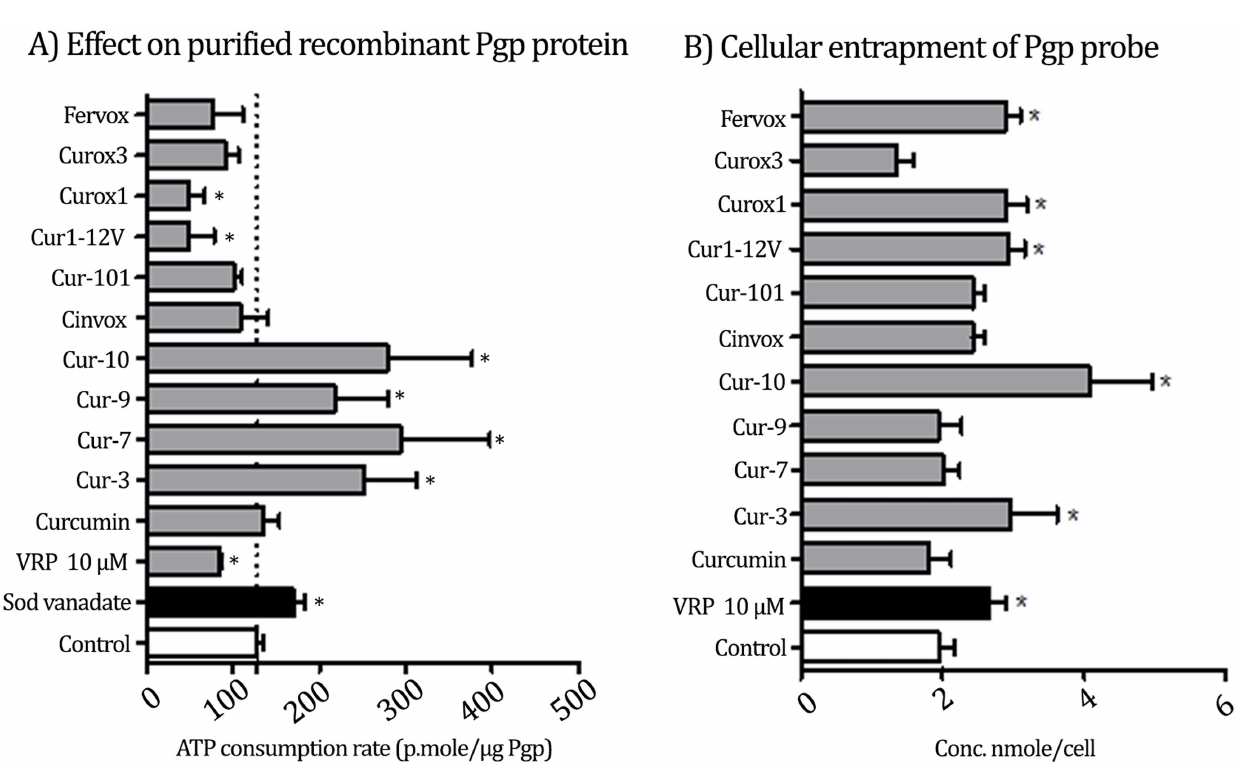
Fig 4. (A) The effect of test compounds on the activity of P-glycoprotein efflux pump cell free isolated recombinant P-gp protein and (B) within LS-174T cells. The influenceof test compoundson the cellularpharmacokinetics via inhibitingthe activity of Pgp pump. Verapamil (VRP) is a standard direct Pgp blocker. Sod Vanadateis a standard ATPase inhibitor.Curcuminis the prototype compoundin the design. The asterisk ( * ) denotessignificantdifference from